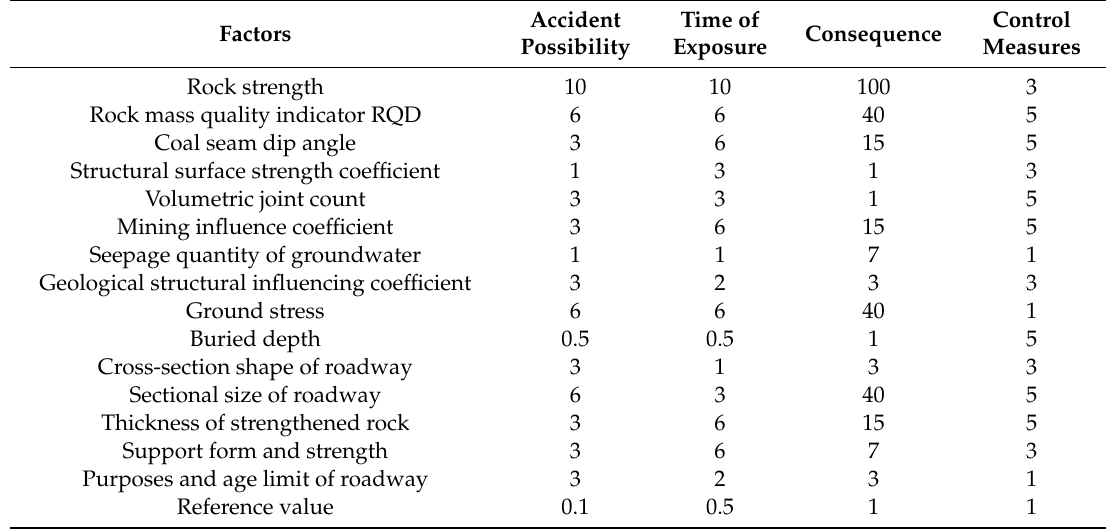
Table 4. Parameter sequence of each factor and reference sequence.